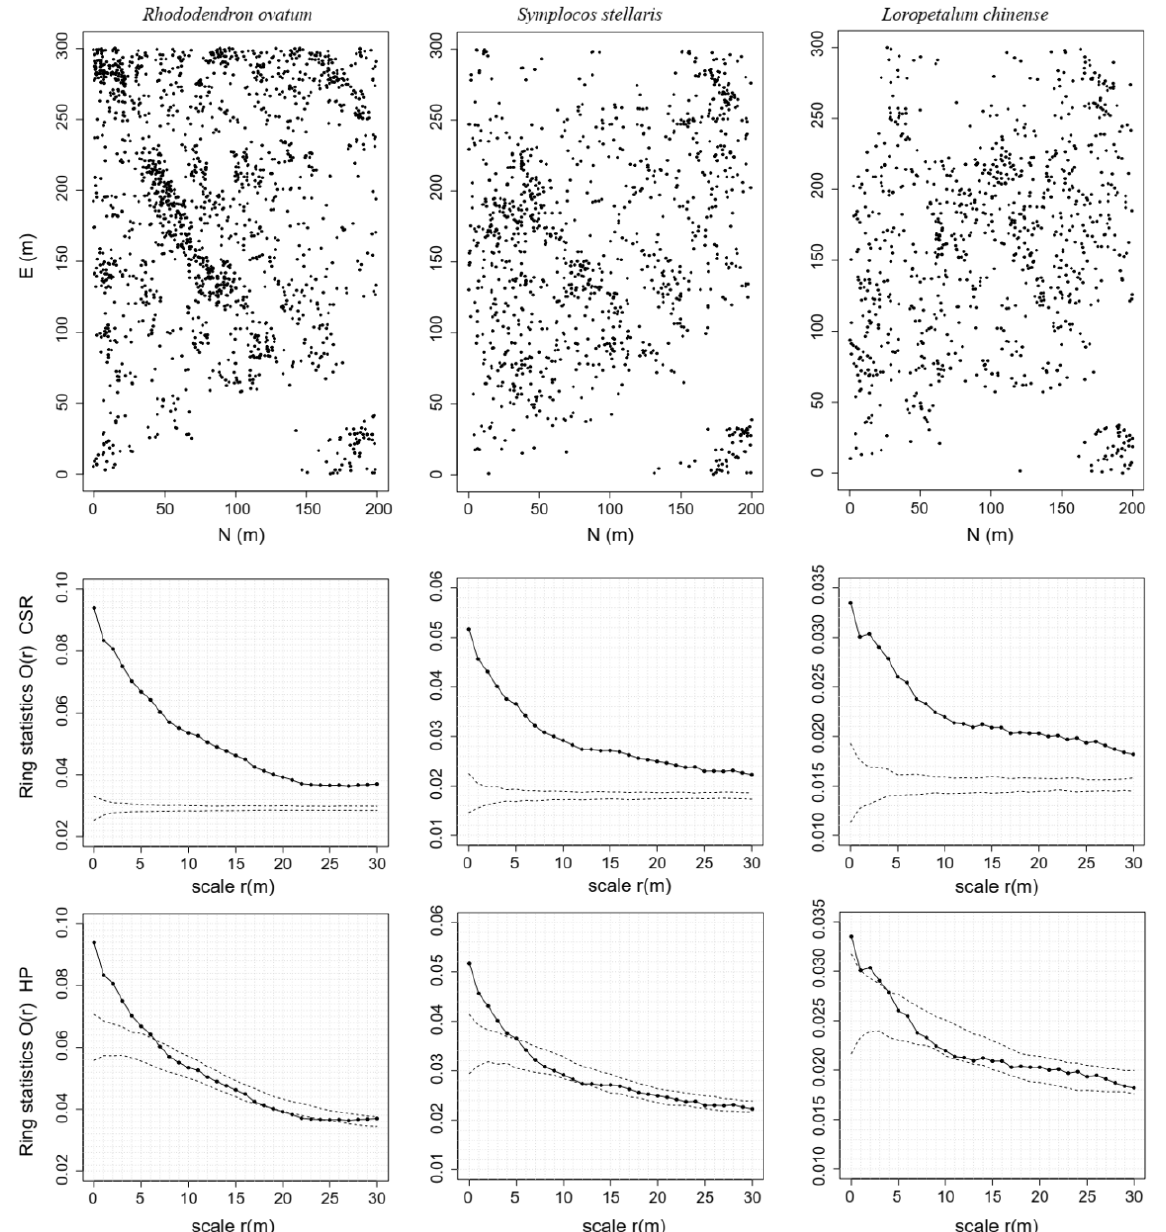
Figure 4. Spatial distribution scatter diagram and univariate point pattern analyses of Rhododendron ovatum , Symplocos stellaris , and Loropetalum chinense.